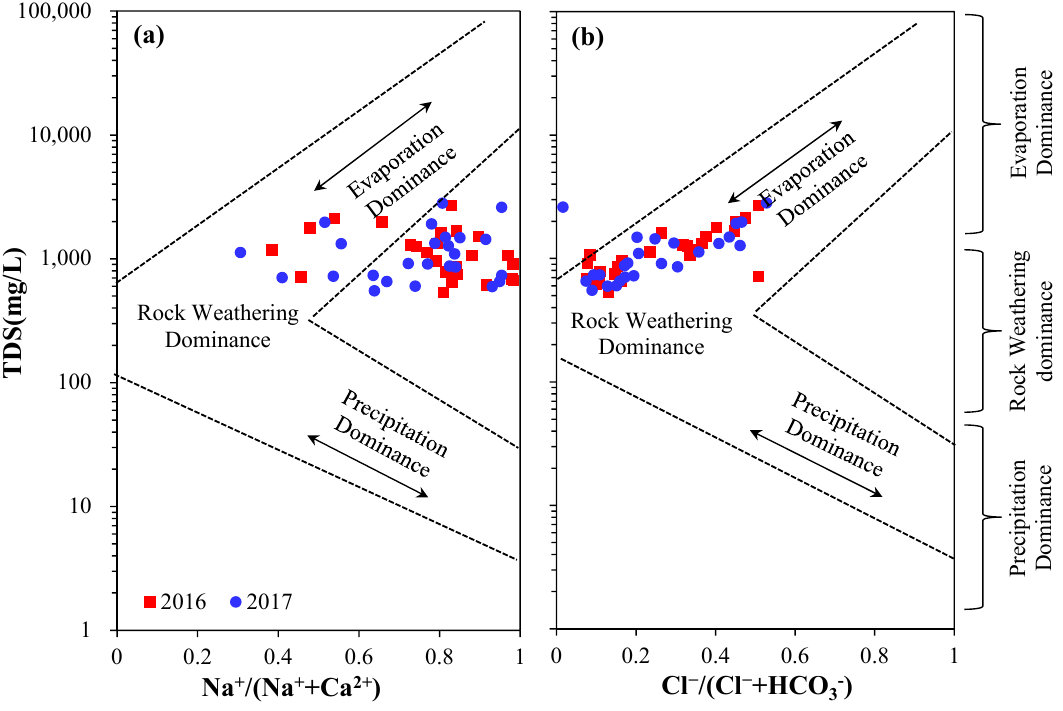
Figure 4. Gibbs diagram for groundwater samples.